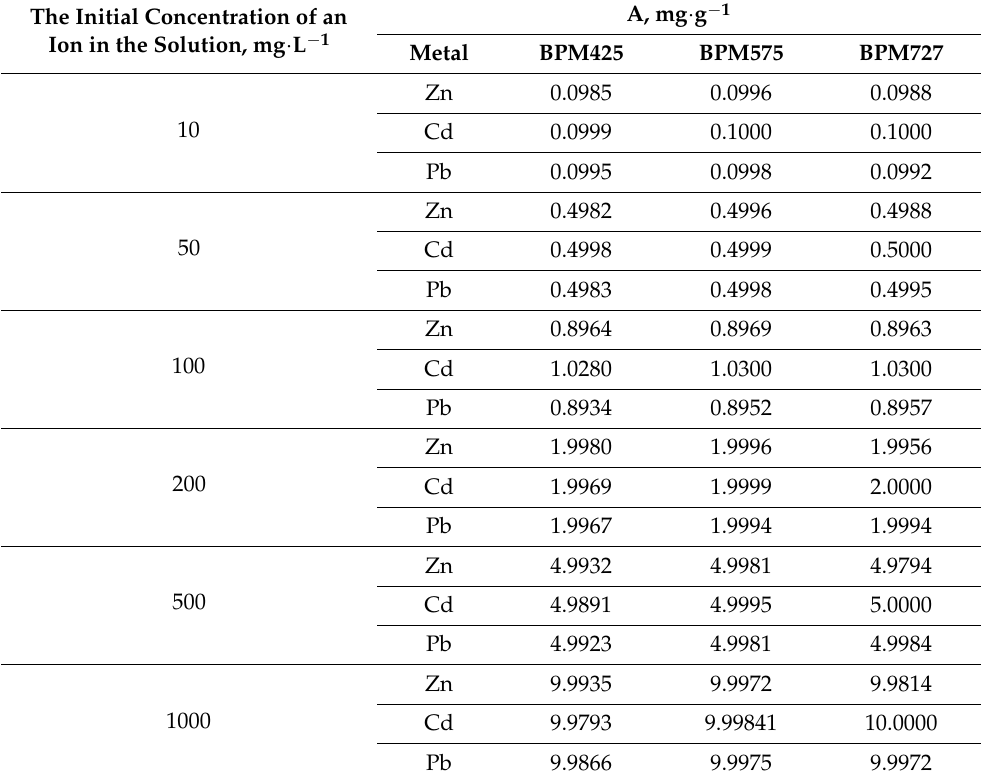
Table 7. The obtained values of adsorption of single metal ions for the investigated biochars in relation to the initial metal concentration in the